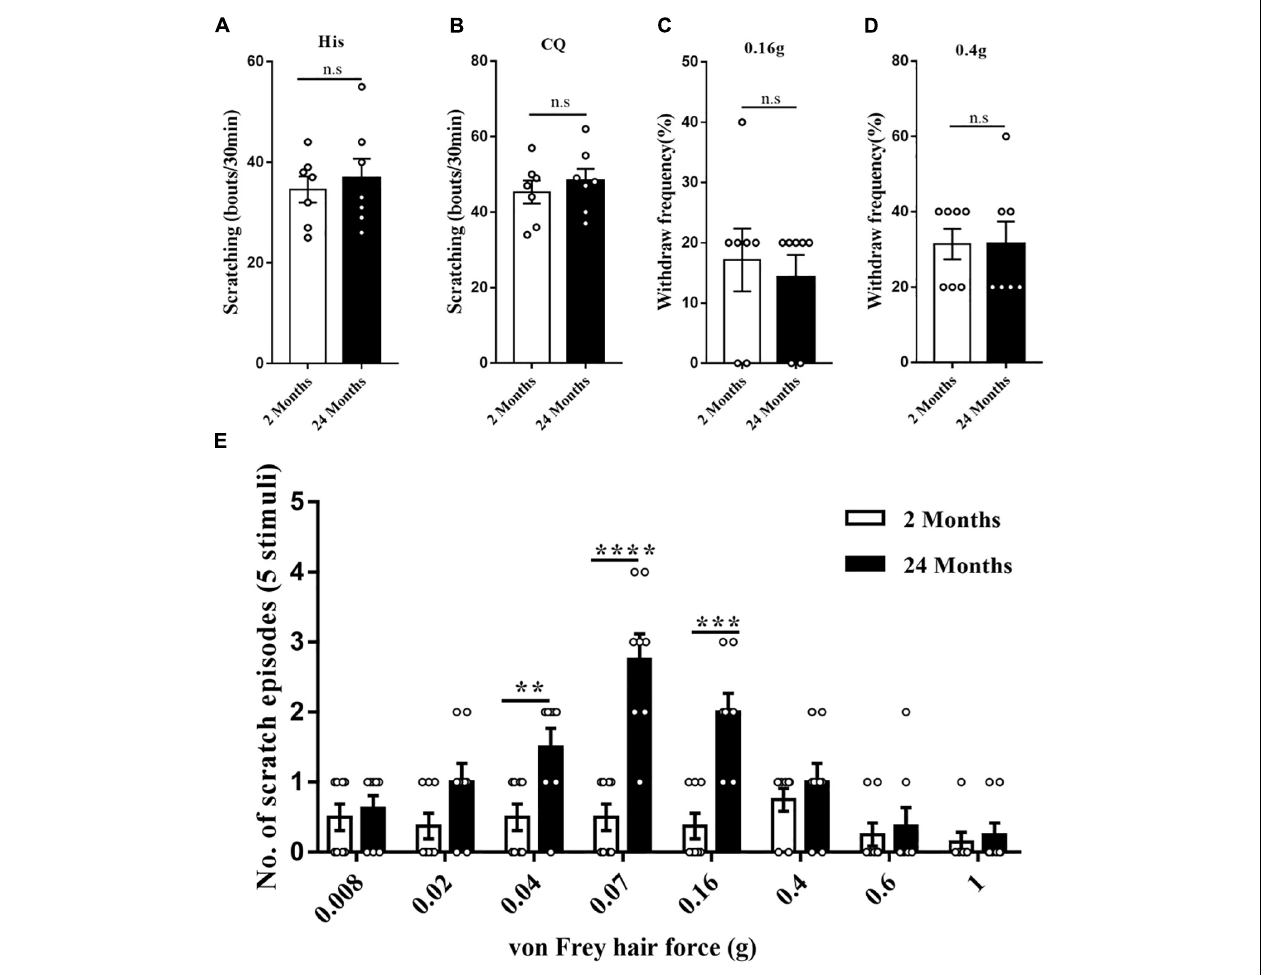
FIGURE 2 | The enhanced mechanical itch in aged mice. (A) Scratching responses to intradermal injections of histamine in young (2 months, n = 7, 4 male and 3 female) and aged (24 months, n = 7, 4 male and 3 female) mice. n.s, not significant, Student’s t -test. (B) Scratching responses to intradermal injections of chloroquine in young (2 months, n = 7, 4 male and 3 female) and aged (24 months, n = 7, 4 male and 3 female) mice. n.s, not significant, Student’s t -test. (C,D) Percent paw withdrawal responses of young and aged mice to 0.16 (C) and 0.4 g (D) von Frey filament stimulation. n = 7 mice (4 male and 3 female) for